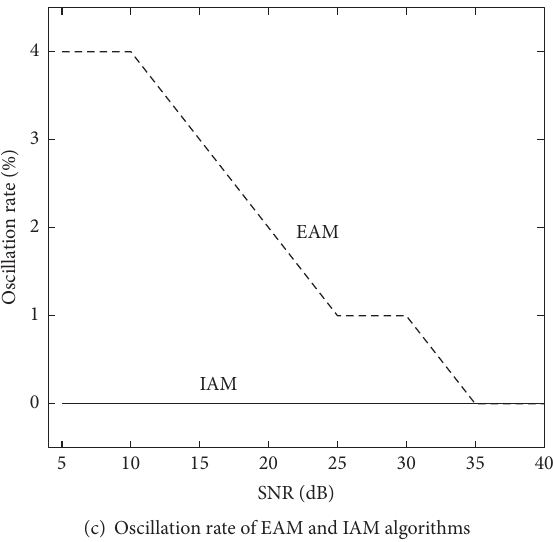
Figure 2: Oscillation in EAM algorithm while not in